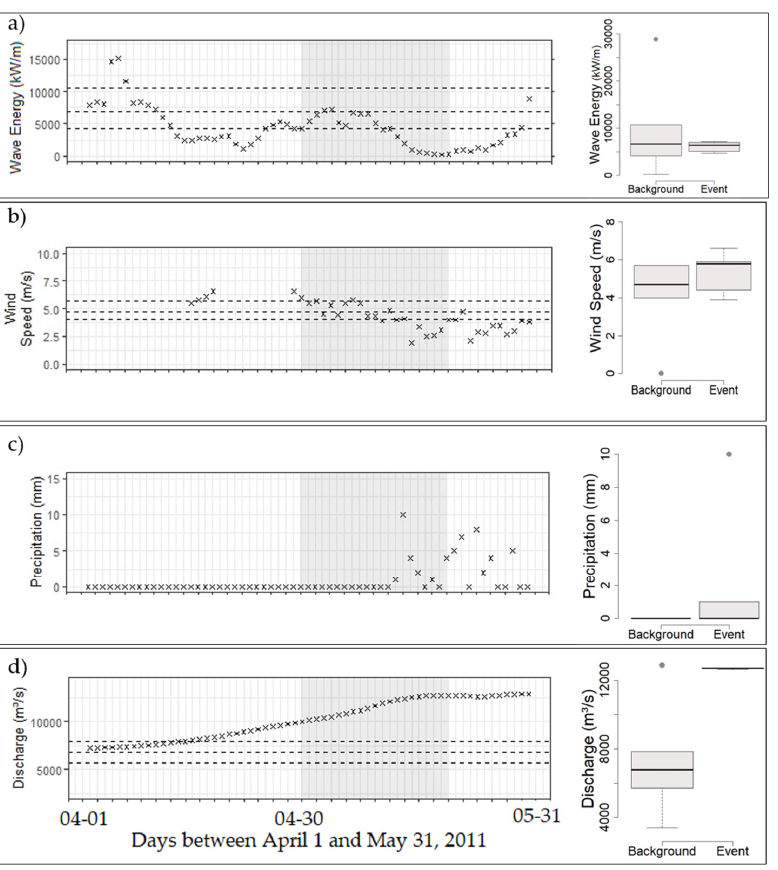
Figure 9. Time series of potential drivers of a lagoon breaching in April–May 2011. The left panels indicate daily maximums for ( a ) wave energy, ( b ) wind speed, ( c ) precipitation, and ( d ) the Magdalena River discharge. Dashed lines show the 25th, 50th, and 75th percentiles for non-event conditions (background), and crosses indicate the conditions before, during (grey shaded area), and after a breaching event. Box plots on the right panels help visualize DBM/OVS ratios reported in Table